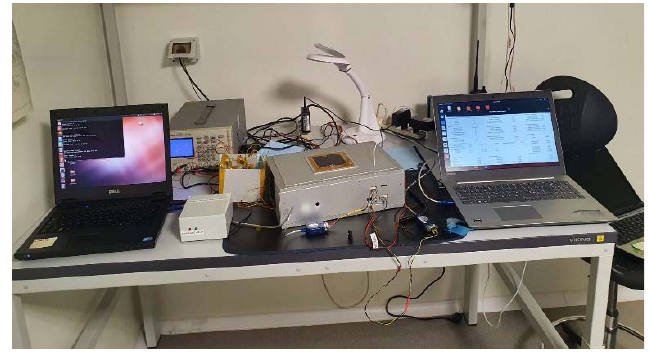
Figure 5. Setup of the Functional Tests.